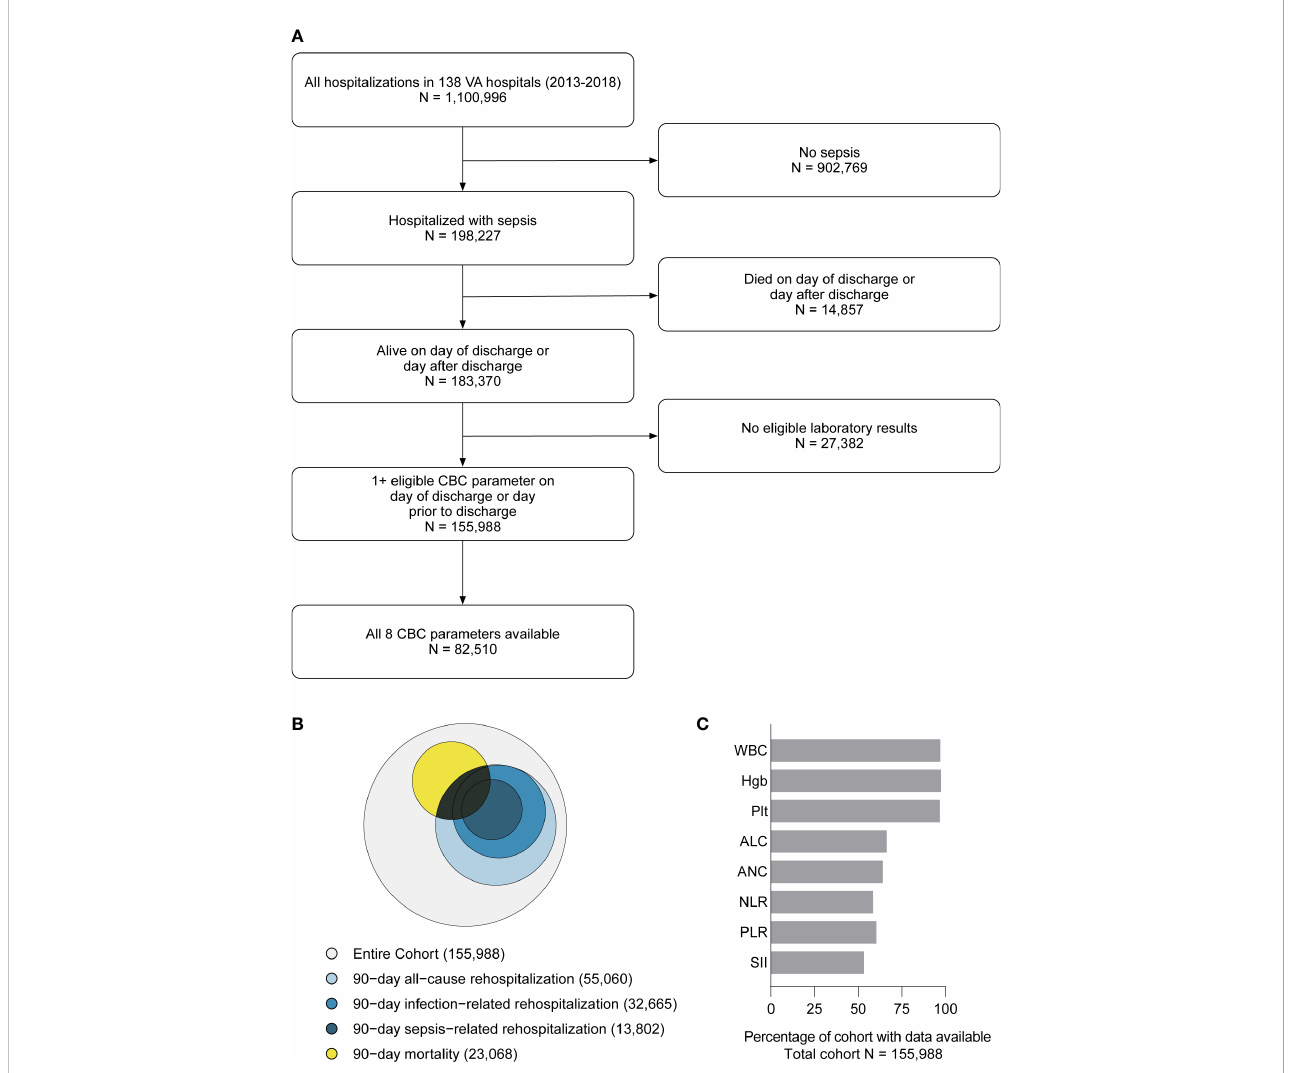
FIGURE 1 Flow diagram showing study inclusion/exclusion criteria and the fi nal cohort (A) . Euler diagram (proportional Venn diagram) showing the relative proportion of the cohort experiencing each component 90-day outcome, including mortality (yellow), all-cause re-hospitalization (light blue), infection- related re-hospitalization (blue), and sepsis-related rehospitalization (dark blue) (B) . Each discharge CBCD parameter was available for the majority of the hospitalizations (C) . WBC, total white blood cell count. Hgb, hemoglobin. Plt, platelet count. ANC, absolute neutrophil count. ALC, absolute lymphocyte count. NLR, neutrophil-to-lymphocyte ratio (NLR = ANC/ALC). PLR, platelet-to-lymphocyte ratio (PLR = Plt/ALC). SII, systemic immune-in fl ammation index (SII = ANC x